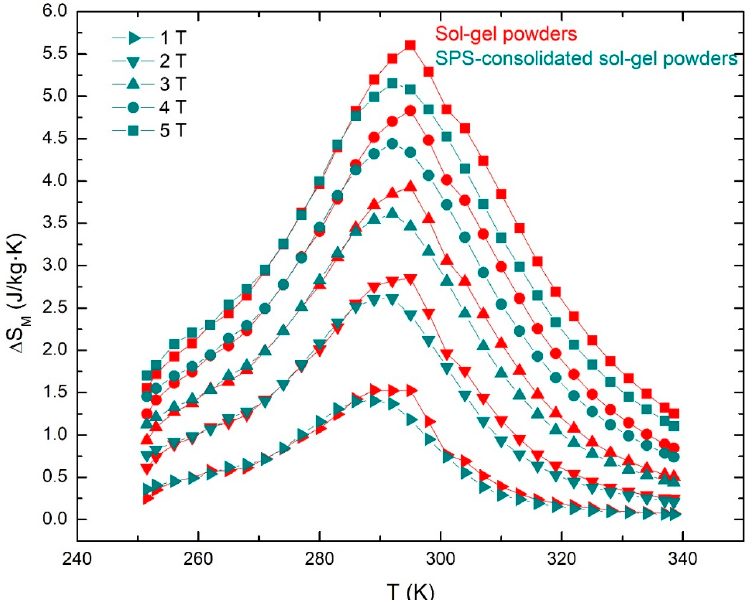
Figure 9. ∆ S M (T) curves with applied field of 10 kOe to 50 kOe for sol-gel powders and Spark Plasma Sintering (SPS)-consolidated sol-gel powders. ( Δ S M ) max values of 5.3 × 10 − 4 J/kg·K and 5.16 × 10 − 4 J/kg·K were obtained for powders and SPS-